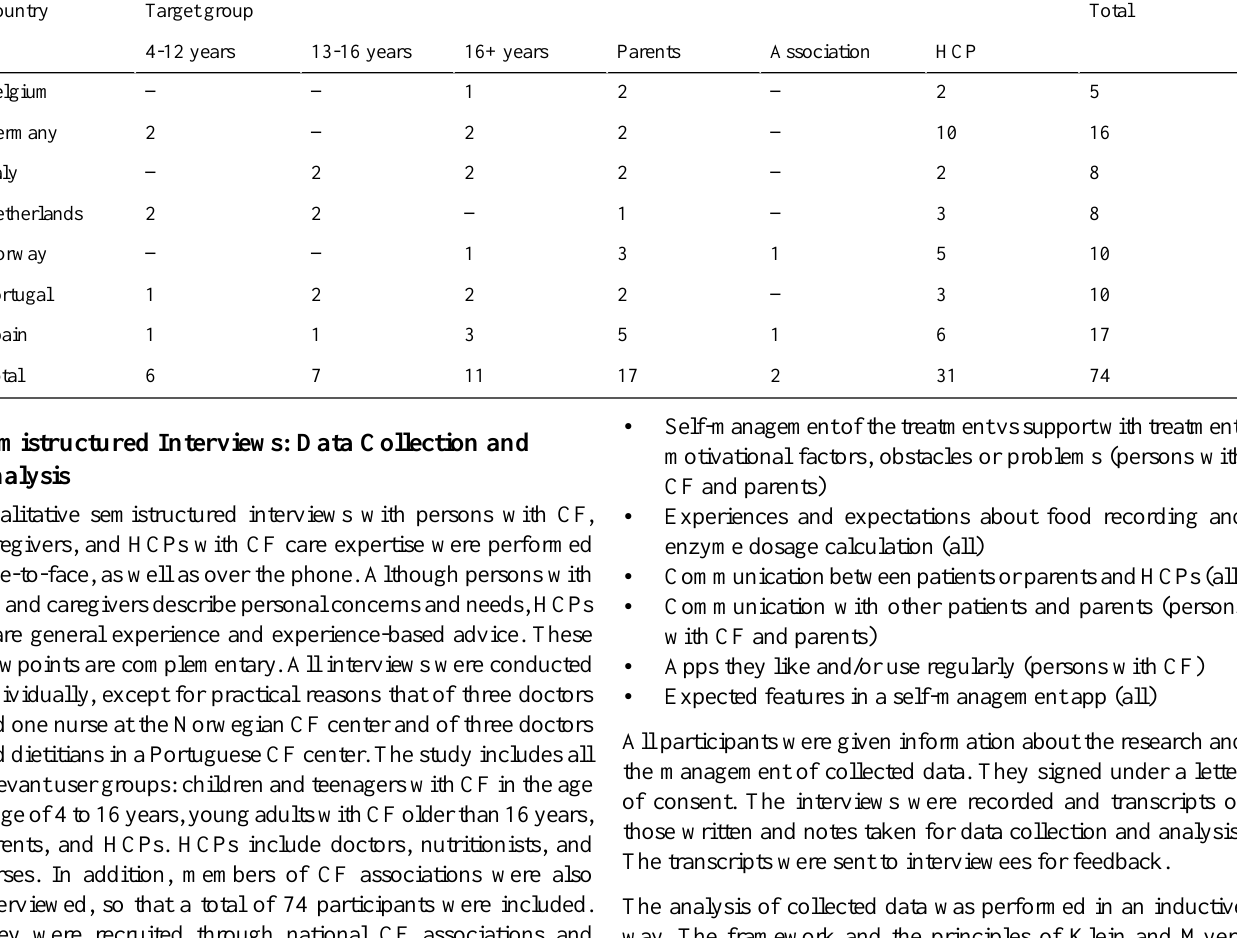
Table 1. Overview of the participants across countries and target groups. TotalTarget